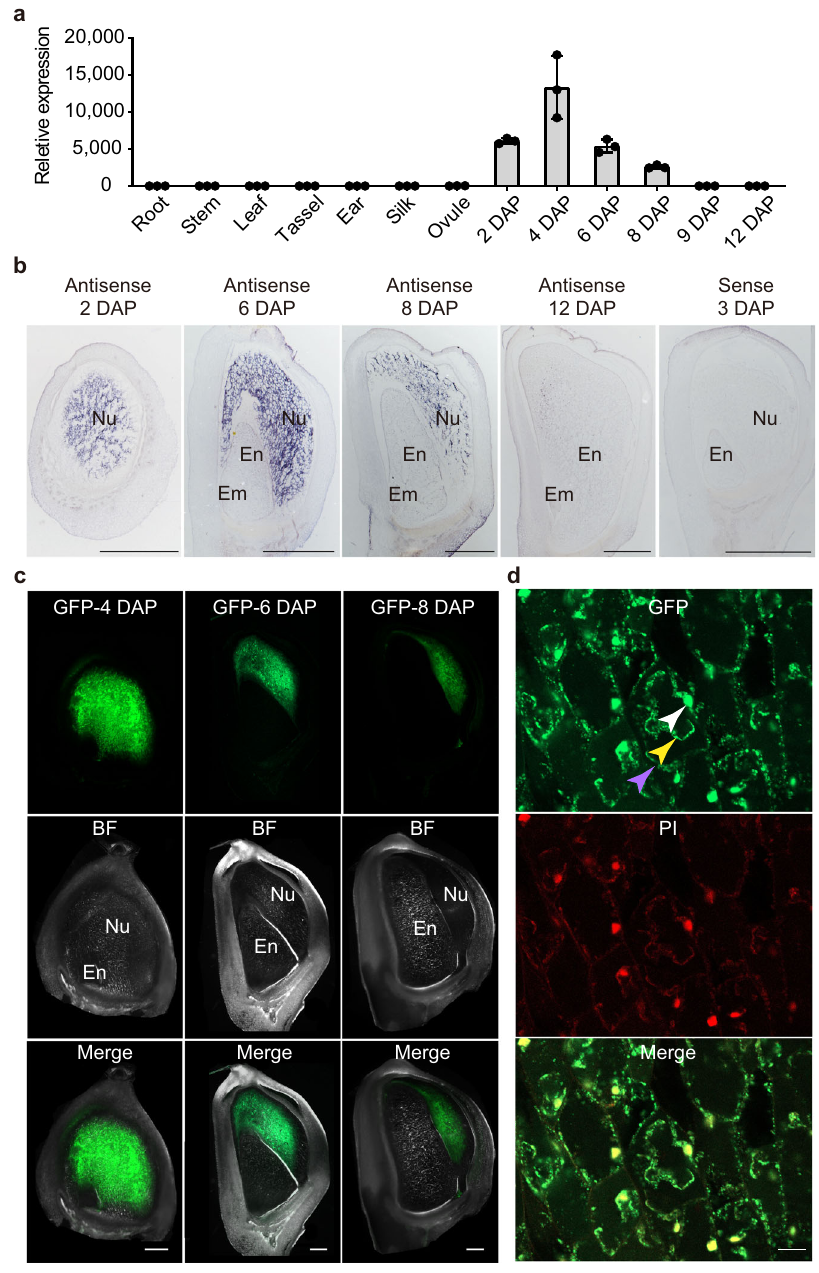
Fig. 3 | ZmEXPB15 accumulates speci fi cally in nucellus of developing kernels. a qRT-PCR analysis of ZmEXPB15 in root, stem, leaf, tassel, ear, silk and developing kernels at 0 (ovule) to 12 DAP. All expression levels from three biological repeats werenormalizedto Actin .Valuesaremeans±s.d. b Insitulocalizationof ZmEXPB15 mRNA in developing kernels at 2 to 12 DAP. Positive signals (shown in purple) are clearly restricted to the nucellus at 2 to 8 DAP ( fi rst three panels) using the ZmEXPB15 antisense probe. No signal is observed in the section of a 12-DAP kernel (fourth panel). The control was performed using 3-DAP kernel with a ZmEXPB15 sense probe (last panel). c Localization of ZmEXPB15-GFP in developing kernels at